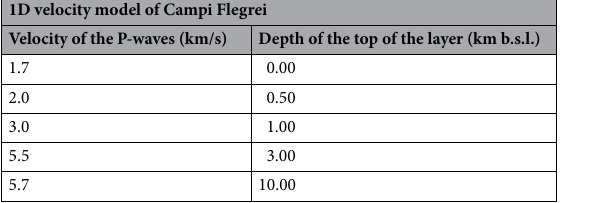
1D velocity model of Campi Flegrei Velocity of the P-waves (km/s) Depth of the top of the layer (km